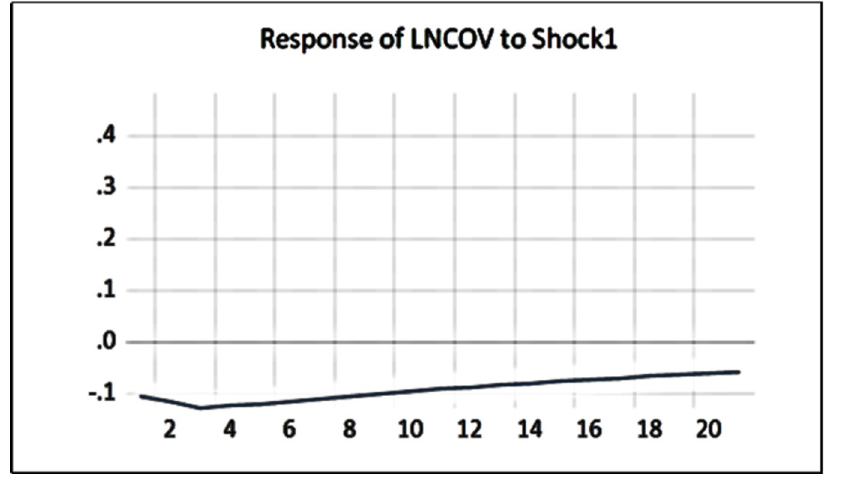
Fig 6. Model impulse response